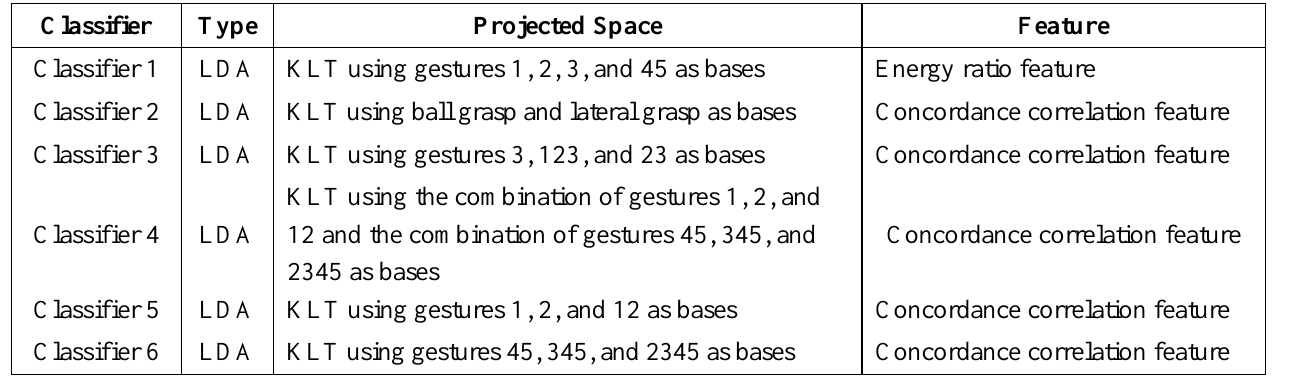
Table 1. Cascaded-classifier of the first